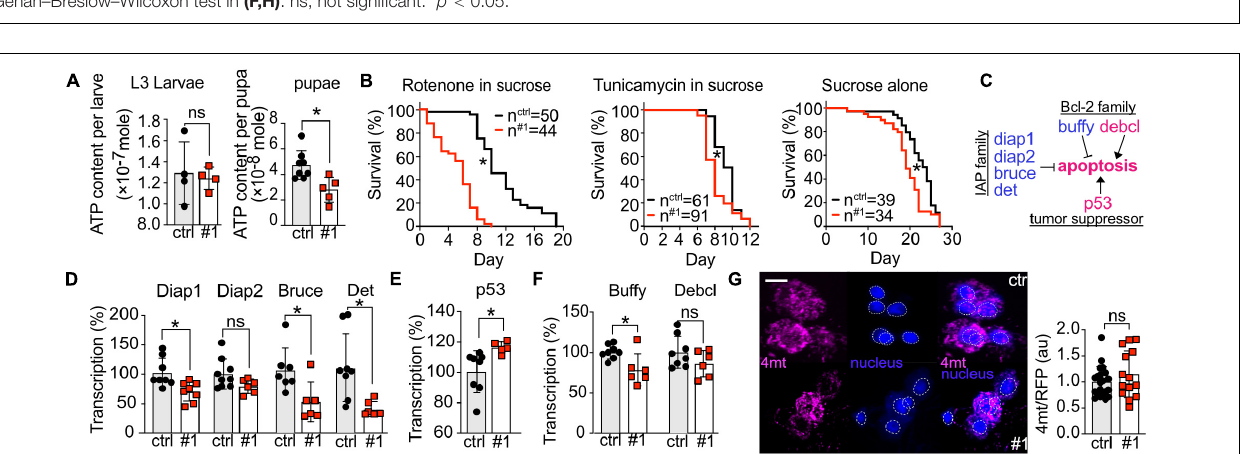
FIGURE 4 | Ubiquitous knockdown of the putative TMBIM5 orthologues results in male sterility for CG1287/Mics1 and arrested development at the pupa stage for dTmbim5. (A) Genomic organization of CG1287/Mics1 which is encoded by a single unspliced exon. Lighter color represents the UTR and the darker color the open reading frame. The targeting sequence of the RNAi line is indicated. (B) Viability and male fertility of CG1287/Mics1 KD flies by RNAi driven by tubP- and elav-Gal4 at 29 ◦ C. (C) Transcriptional levels of CG1287/Mics1 quantified by qPCR from adult female or male tubP > > Mics1-RNAi flies raised at 29 ◦ C. (D) Splicing isoforms of dTmbim5. Lighter color represents the UTR and the darker color the open reading frame. The targeting sequence of the two RNAi lines is indicated. (E) Viability of dTmbim5 KD flies by two RNAi lines and various Gal4 drivers. Red means arrested development. (F) KD efficiency of UAS-dTmbim5-RNAis (#1, #2) assessed by qPCR from whole tubP > > dTmbim5-RNAi L3 larvae. (G) Eclosion and (H) lifespan of Mef2 > > dTmbim5-RNAi flies. (I) Locomotor activity of Mef2 > > dTmbim5-RNAi #1 larvae and flies. L3, L3 wandering larva; D2, 2-day-old; D30, 30-day-old adult flies. (J) Successful eclosion and (K) lifespan of elav > > dTmbim5-RNAi flies. Ctrl in (C) are UAS-vasa-RNAi flies and UAS-Always-early-RNAi in (F–K) . Bars in (C,F,I,J) represent mean ± SD with each dot representing the mean of five adults in (C) , five larvae in (F) , one larva or 10 adults in (I) , and 50–200 flies in (J) . Statistical significance was calculated using one-way ANOVA followed by the Šídák’s multiple comparisons test in (C,F,J) , two-way ANOVA followed by Tukey’s test in (G,I) and the log-rank test and Gehan–Breslow–Wilcoxon test in (F,H) . ns, not significant. * p < 0.05.